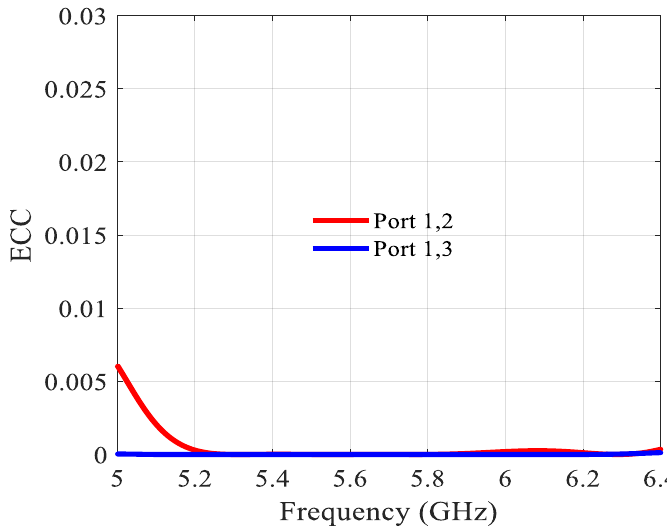
Figure 22. ECC of the 2 × 6 MIMO array.